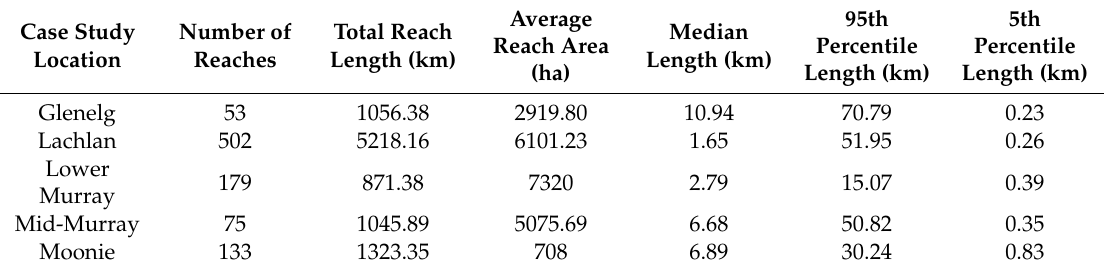
Table 3. Physical characteristics of the reaches in five case